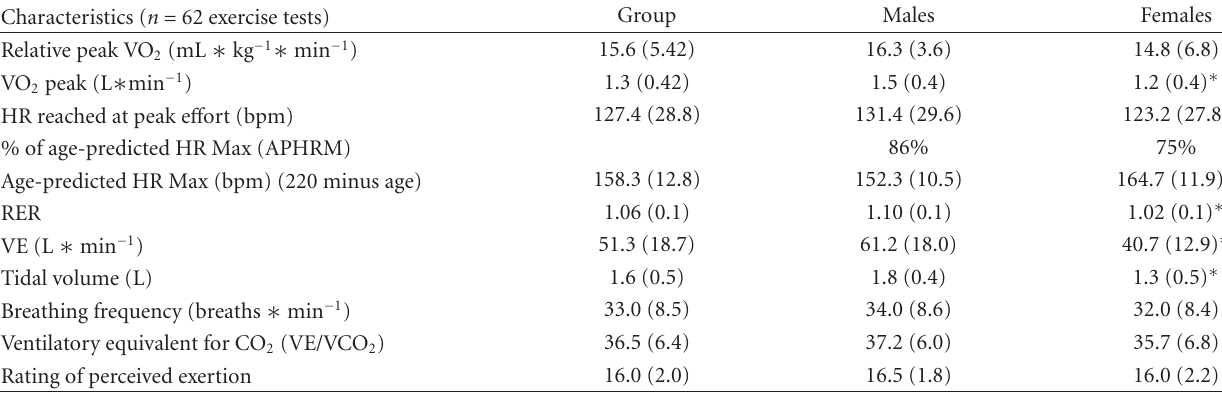
Table 2: Cardiopulmonary response at peak e ff ort in chronic stroke.